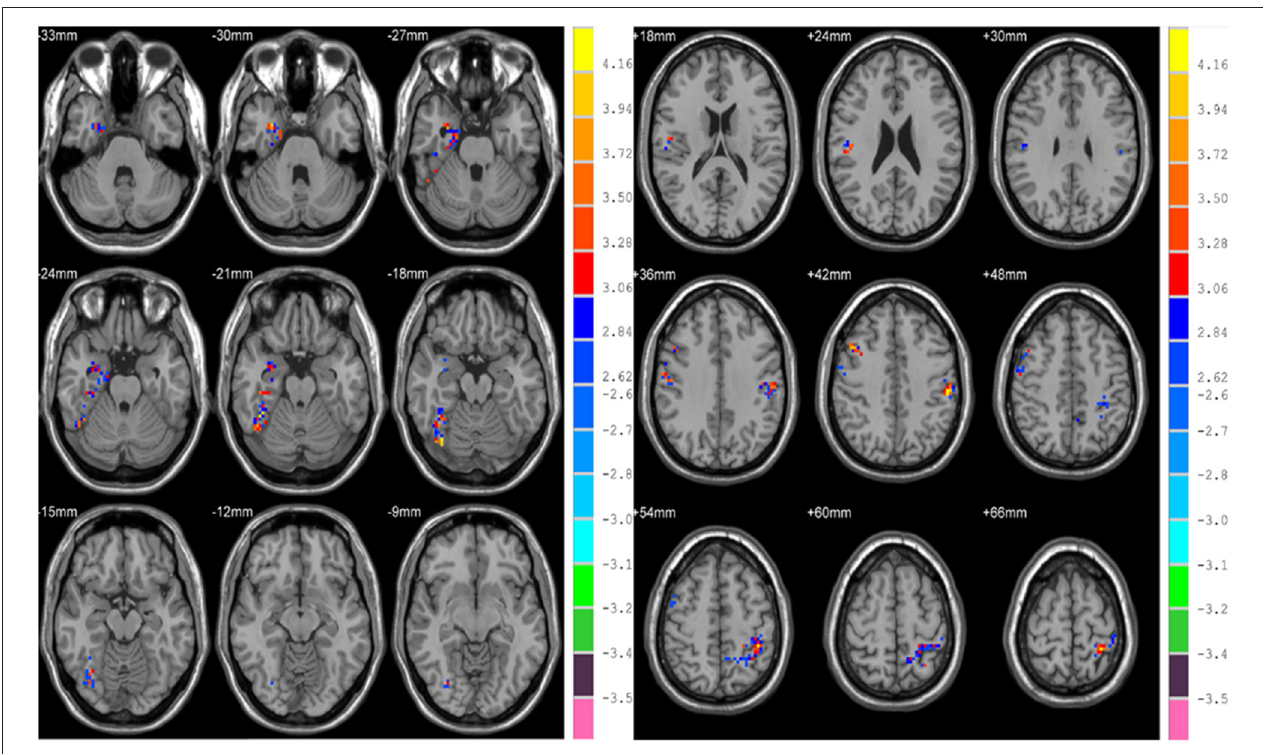
FIGURE 6 | Differences in HE between genders based on voxel-wise analyses.